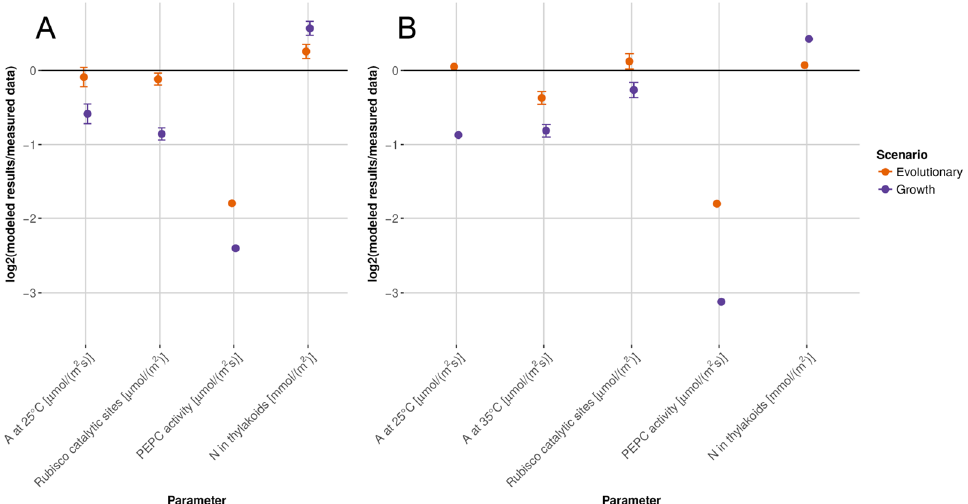
Figure 4. A detailed analysis of resource allocation and physiology in F. bidentis (C 4 ) shows a good agreement between experimental data 56 and model results based on the evolutionary scenario (orange circles). Alternative model results assuming optimal phenotypic adaptation to the EGC consistently show higher disagreement with the data (purple circles). Values are mean log 2 (modeled results/measured data) ± SE. ( A ) Plants grown at 25 °C ( B ) Plants grown at 35 °C. A = net CO 2 assimilation rate; N = nitrogen. See Dwyer, et al. 56 for sample sizes. Figure created using R 4.0 52